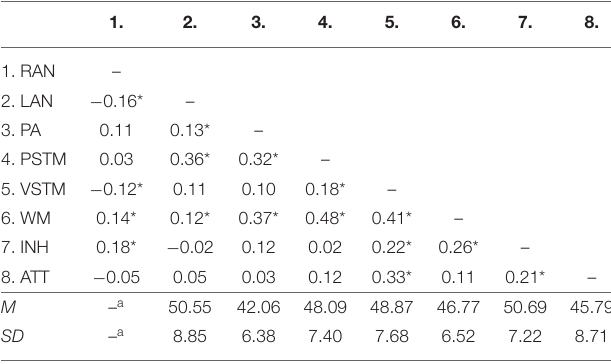
TABLE 2 | Bivariate correlations and norm-referenced means and standard deviations of the sample in the cognitive scales entered in the LPA.